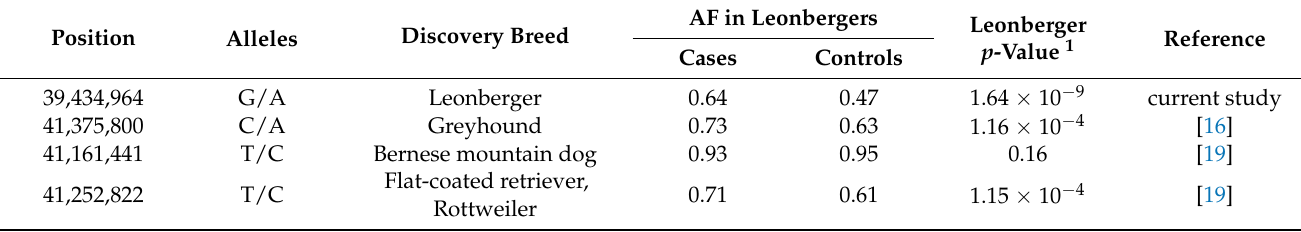
Table 1. Allele frequencies (AF) of OSA-associated SNPs on dog chromosome 11 identified in different studies in the current cohort of 273 cases and 365